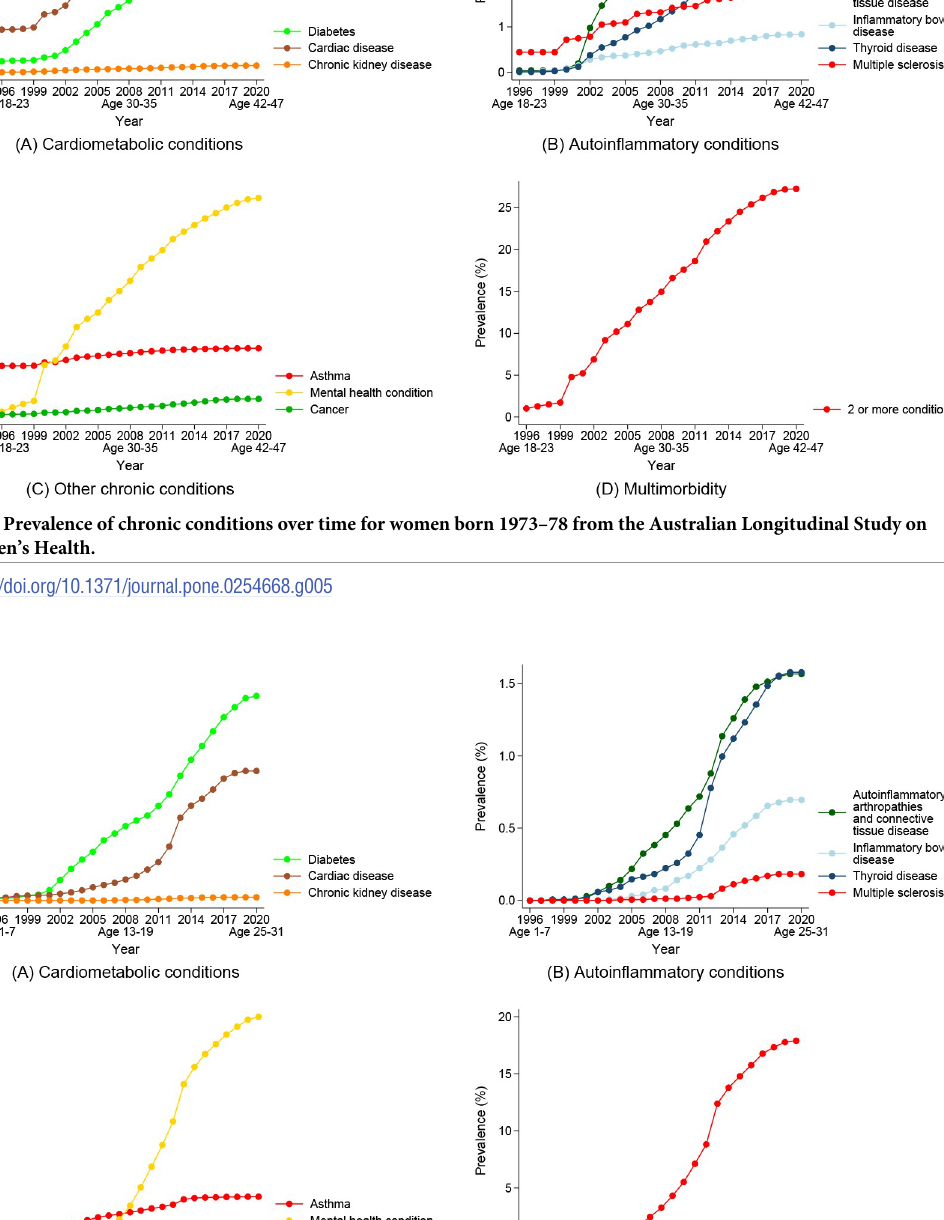
PLOS ONE | https://doi.org/10.1371/journal.pone.0254668 August 18, 2021 13 /